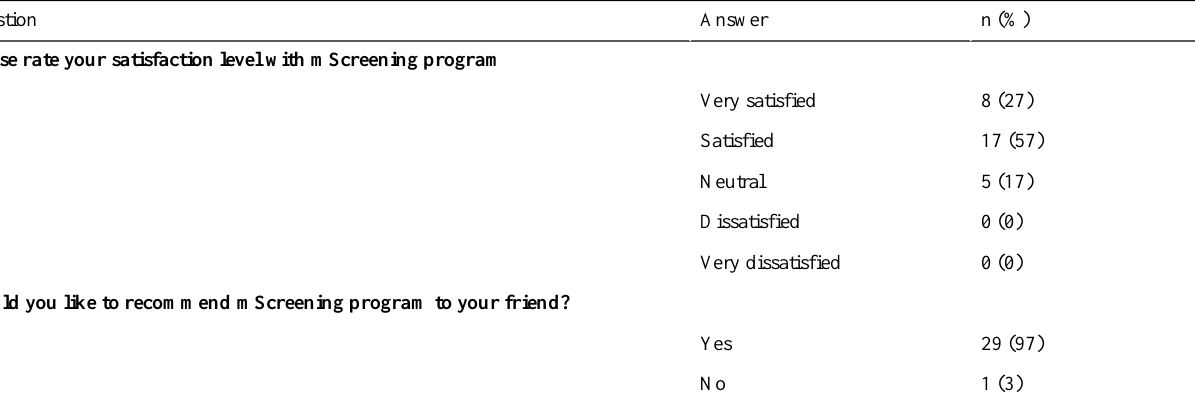
n (%)AnswerQuestion